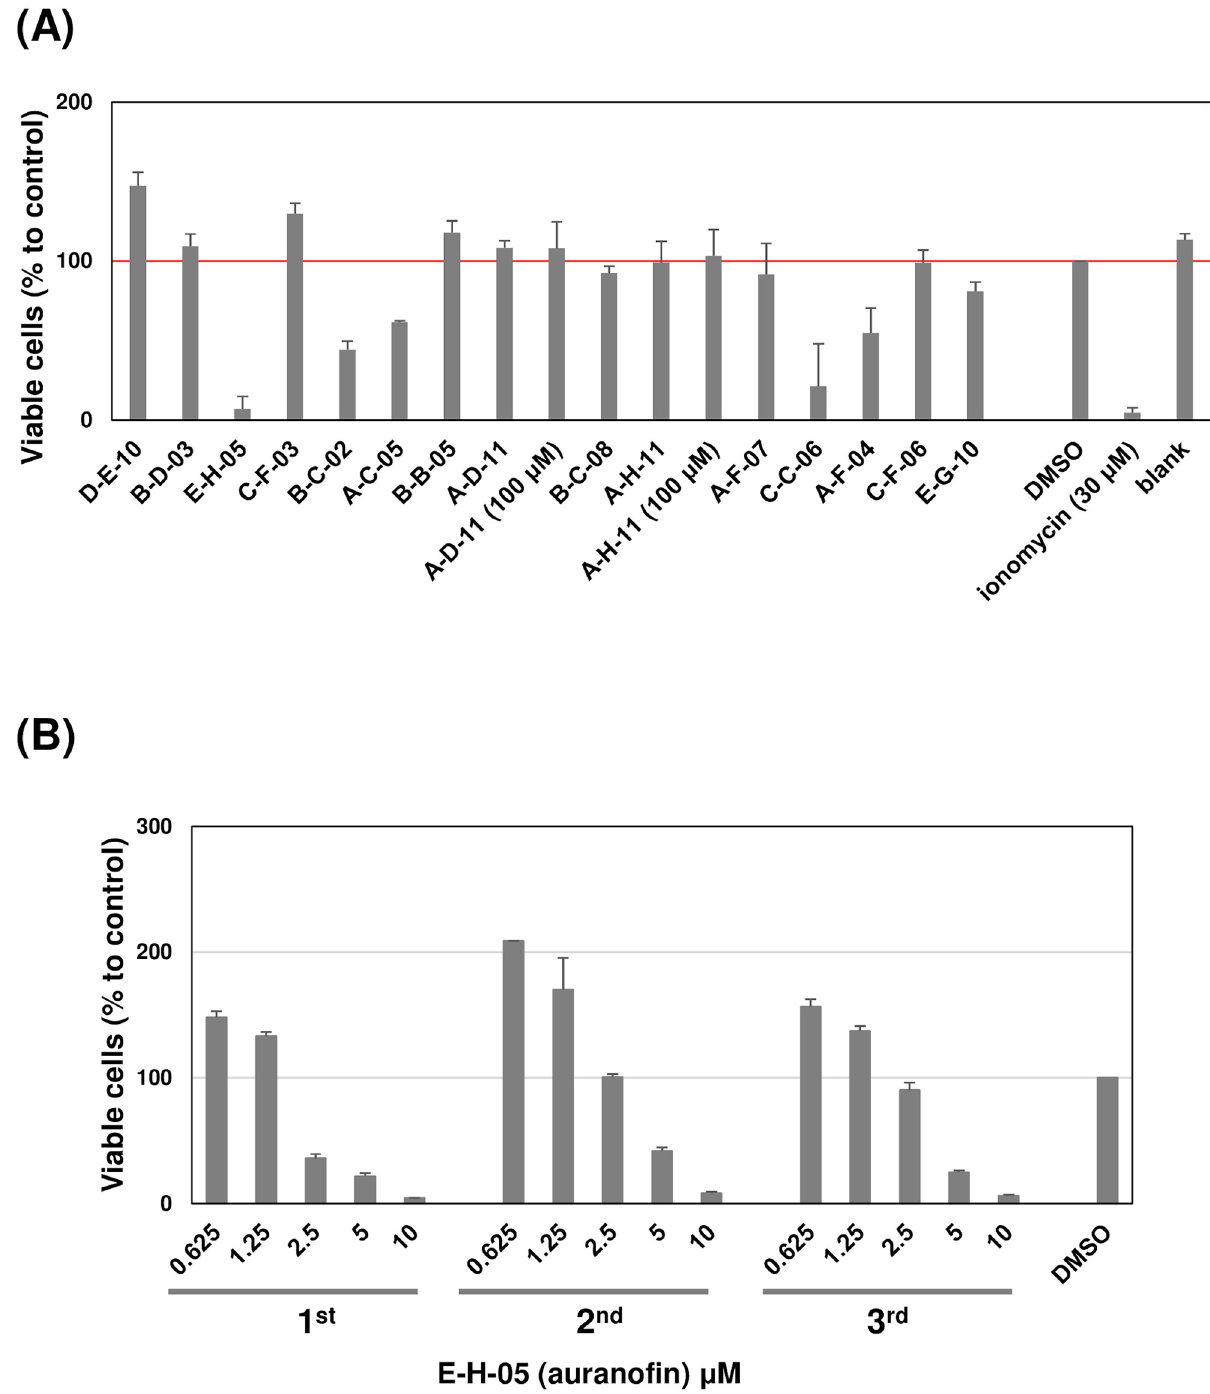
Fig 5. Cytotoxicity of 15 compounds that inhibited rEhAPSK activity against HFF cells. (A) Compound treatments at 10 and 100 μ M. (B) Dose- dependent effect of E-H-05 on number of viable HFF cells. Data are expressed relative to that from a DMSO-treated control (set as 100%). Data shown are the mean with error bar. Error bars indicate deviation from the mean, obtained from duplicates from three independent experiments.